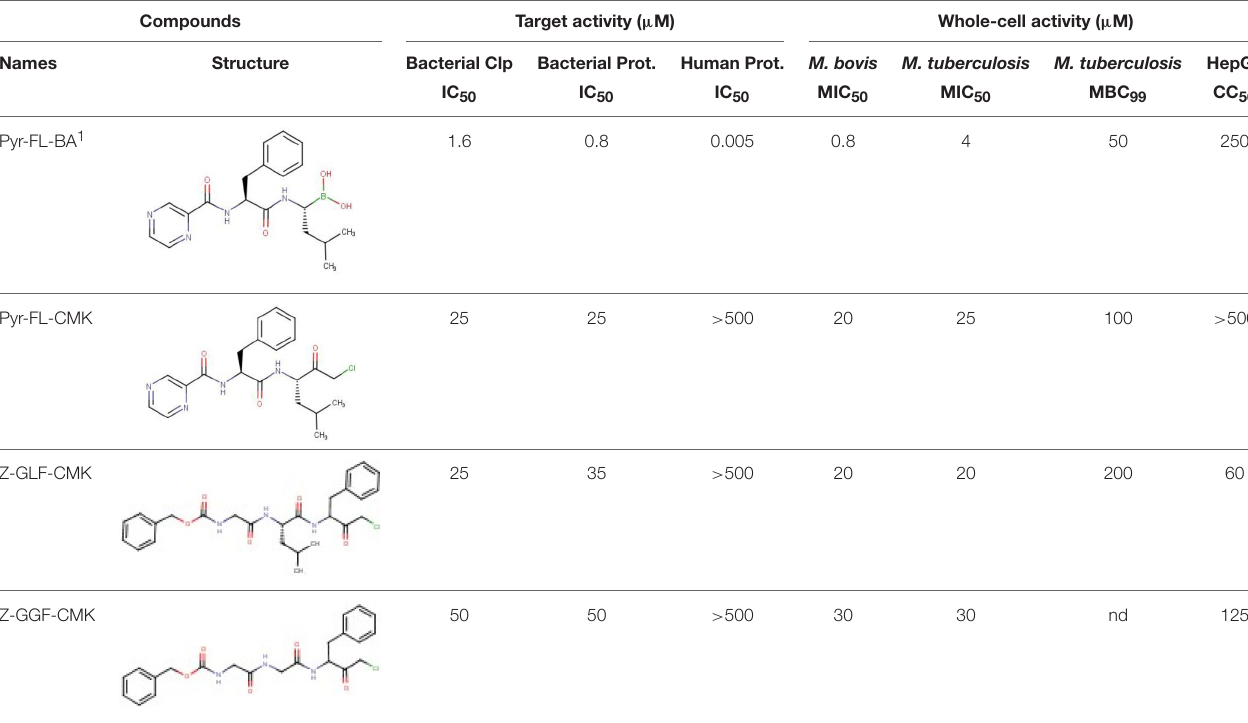
TABLE 1 | Bortezomib and peptidyl-chloromethyl ketones target and whole cell activities.